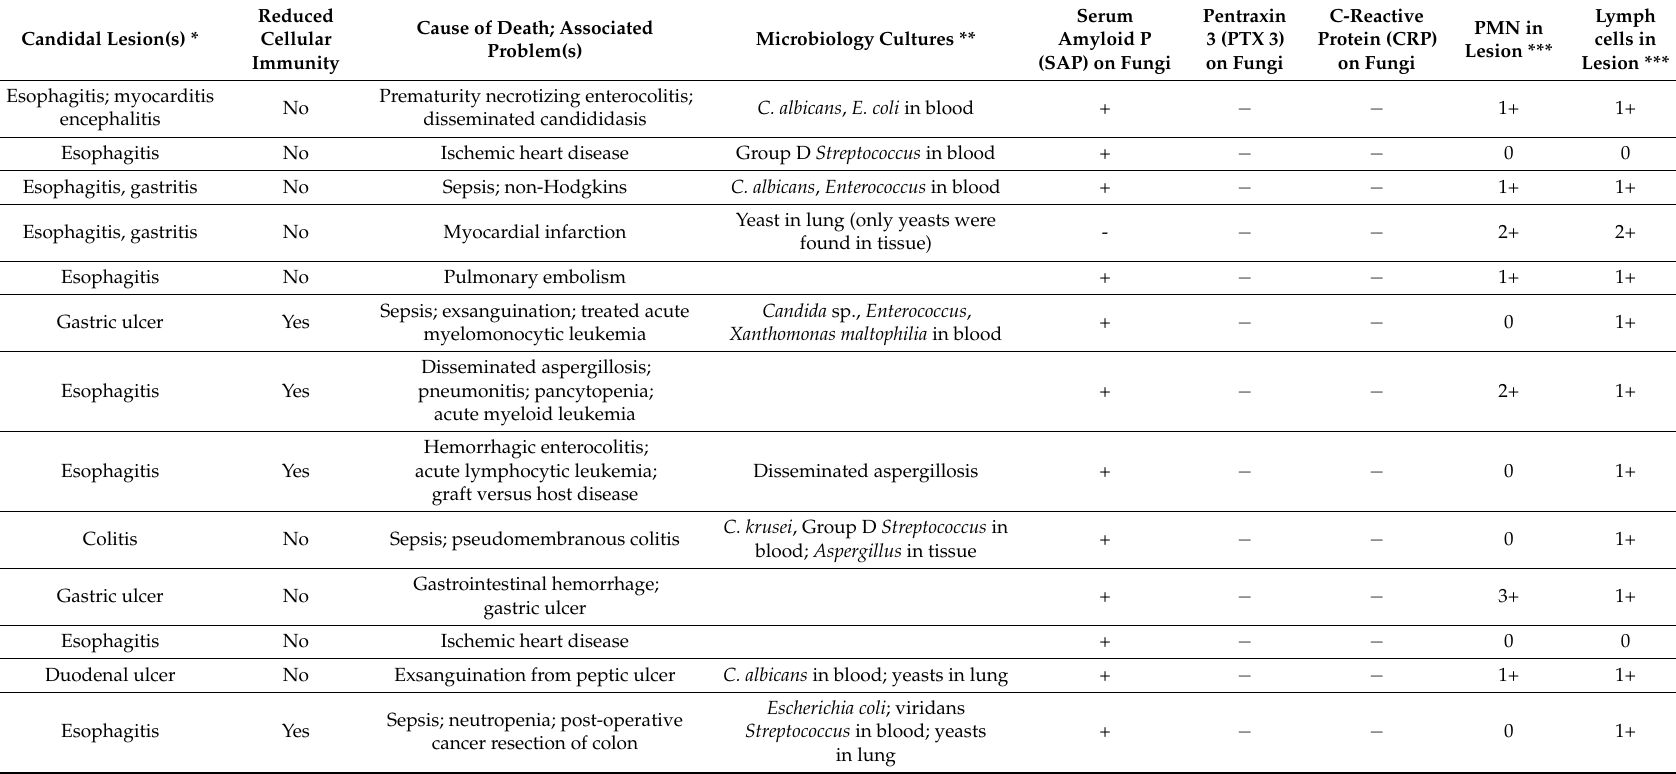
Table 1. Clinical and microscopic findings of 13 gastrointestinal candidiasis autopsy